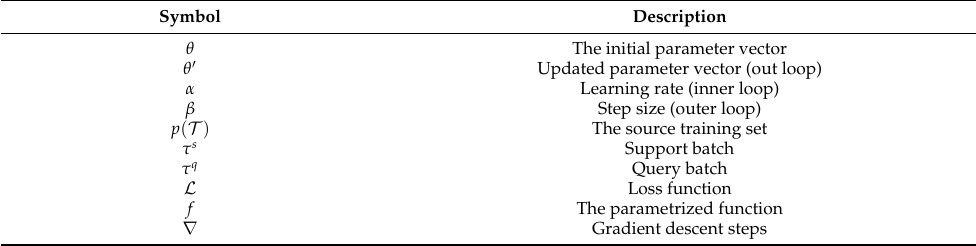
Table 1. All the symbols associated with the proposed